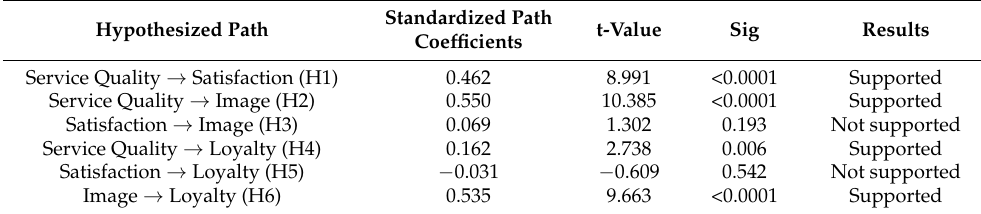
Table 4. Parameter estimates of the structural equation modelling technique.